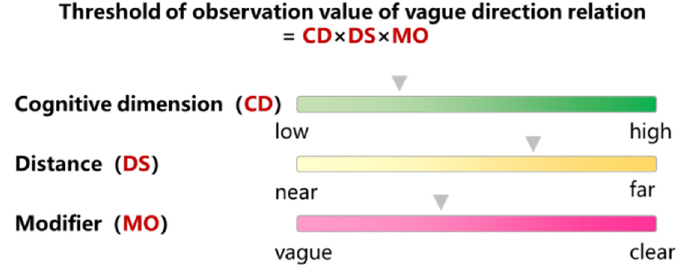
Figure 5. Threshold of observations of vague direction relation.